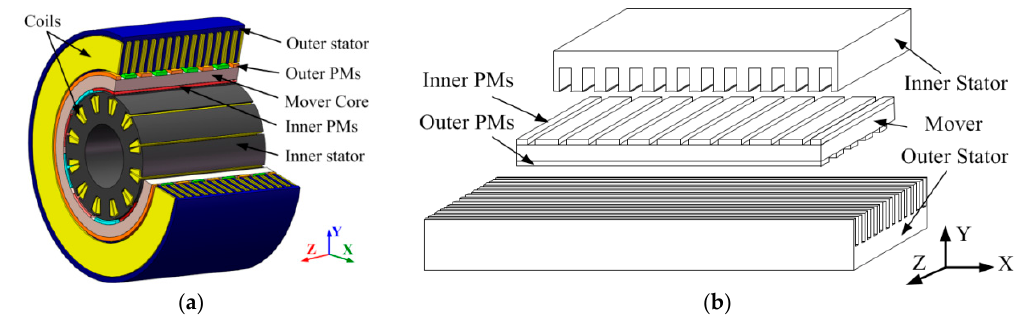
Figure 1. Configuration of the DSLRPMM. ( a ) 3D cutaway view of the DSLRPMM; and ( b ) equivalent planar model of the DSLRPMM.